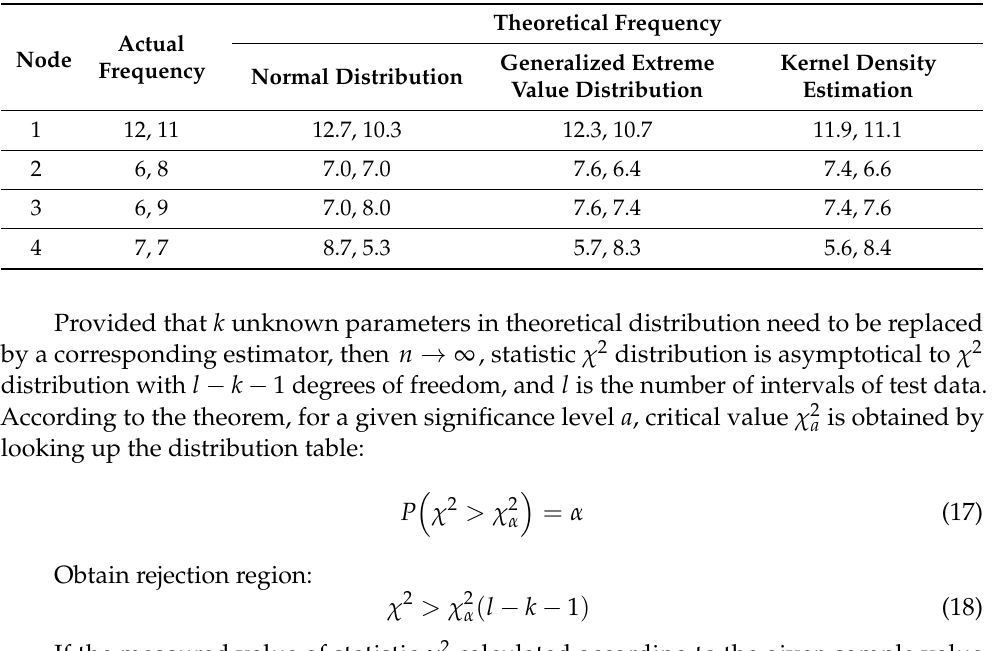
Table 6. Hypothesis test frequency for life